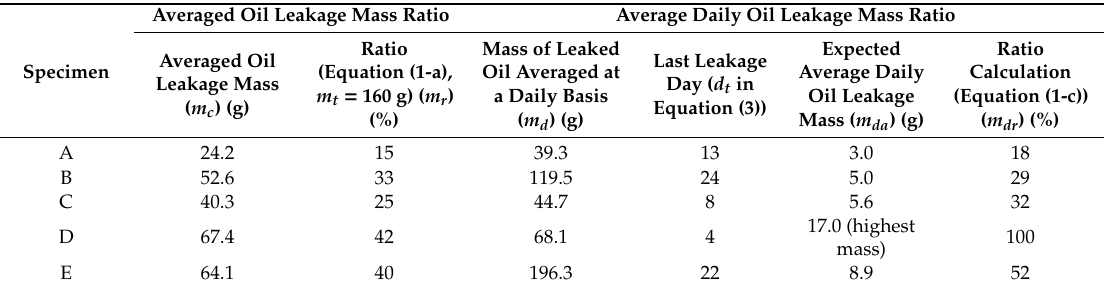
Table 10. Averaged oil leakage mass and average daily oil leakage mass ratio calculation results.